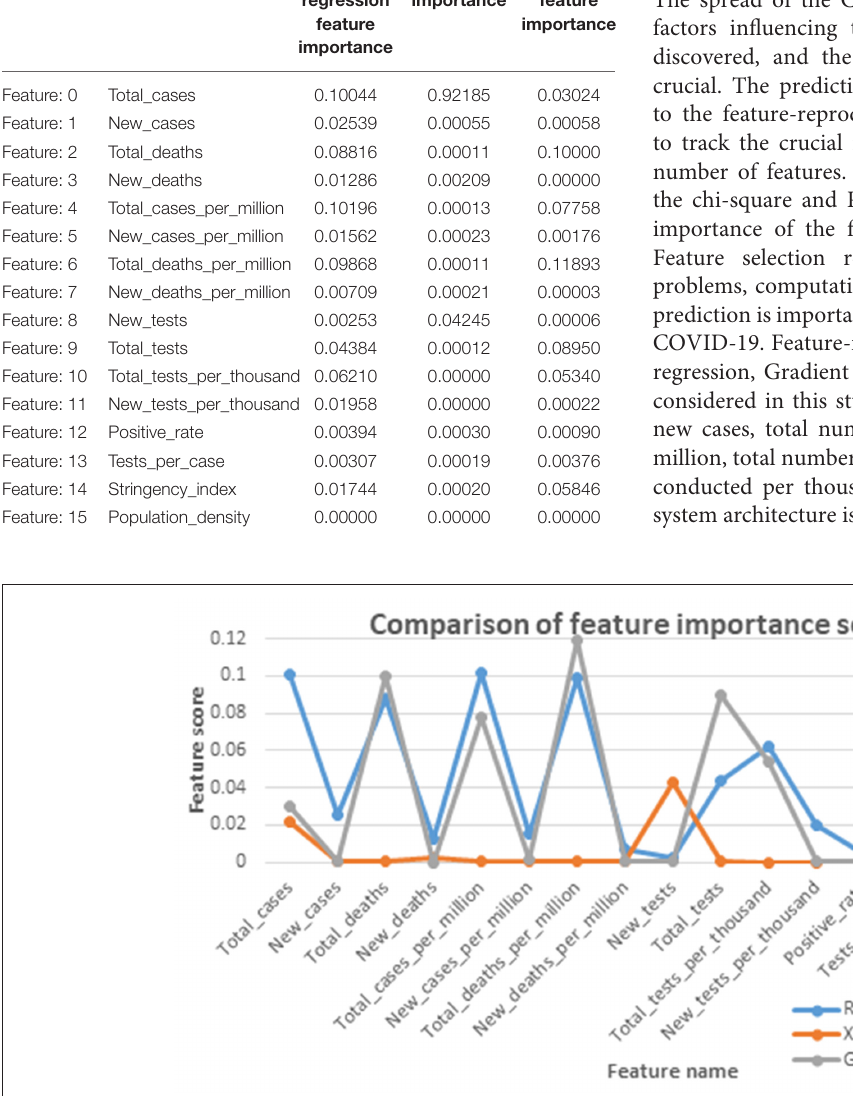
FIGURE 2 | Comparison graph of feature score given by feature selection